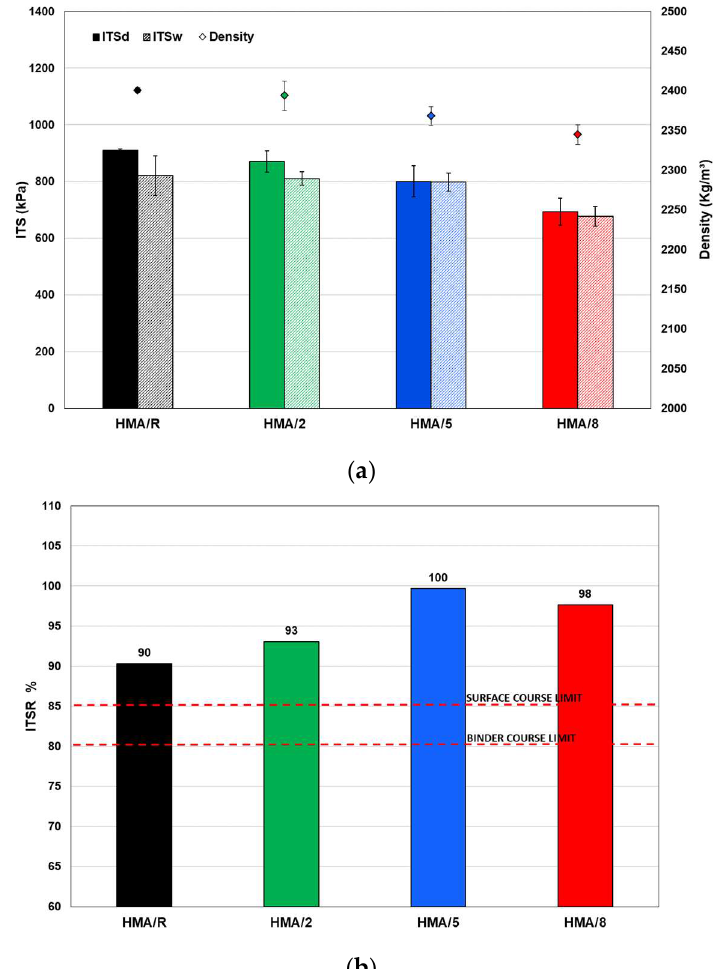
Figure 7. ( a ) Indirect tensile strength of dry and wet samples; ( b ) Indirect tensile strength ratio, for all the studied mixtures.